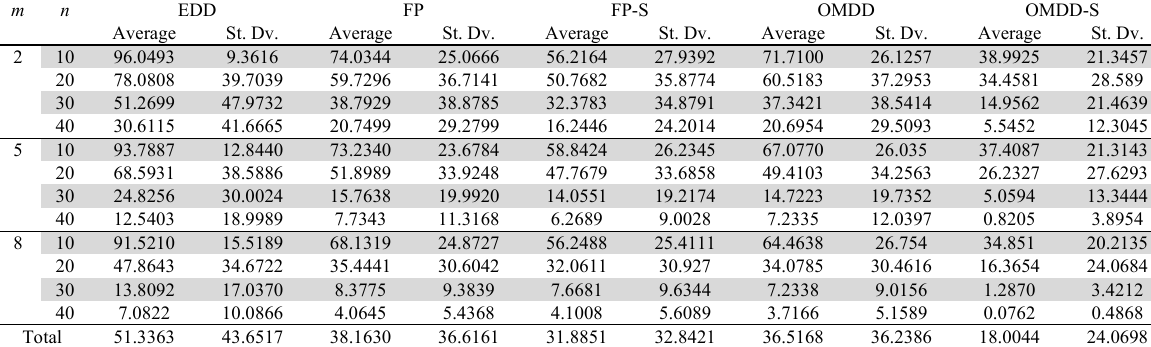
considered methods. However, with the increasing of the values of 𝑚 and 𝑛 , MILP model and SPAM-JPO return the best 𝑅𝐷𝐼 values. Large-sized test instances: RDI values for m and n (part 1)